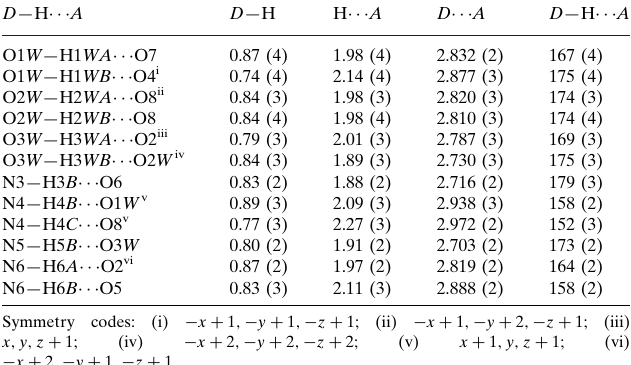
Hydrogen-bond geometry (A˚ , (cid:3) ). D —H (cid:2)(cid:2)(cid:2)